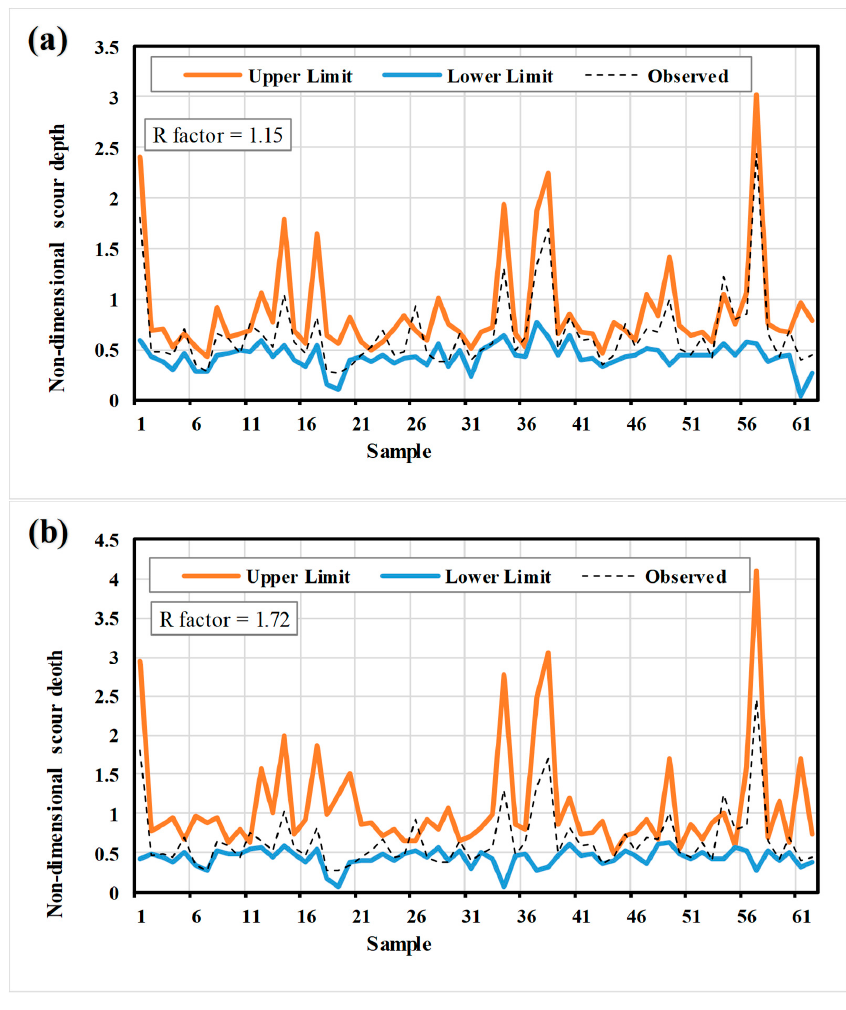
Figure 6. Generated prediction uncertainty band against observed values of scouring depth over testing phase based on ( a ) model structure and ( b ) input